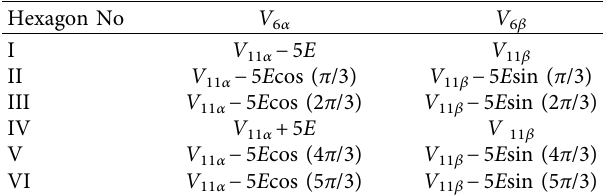
ref6 from V ref11 .